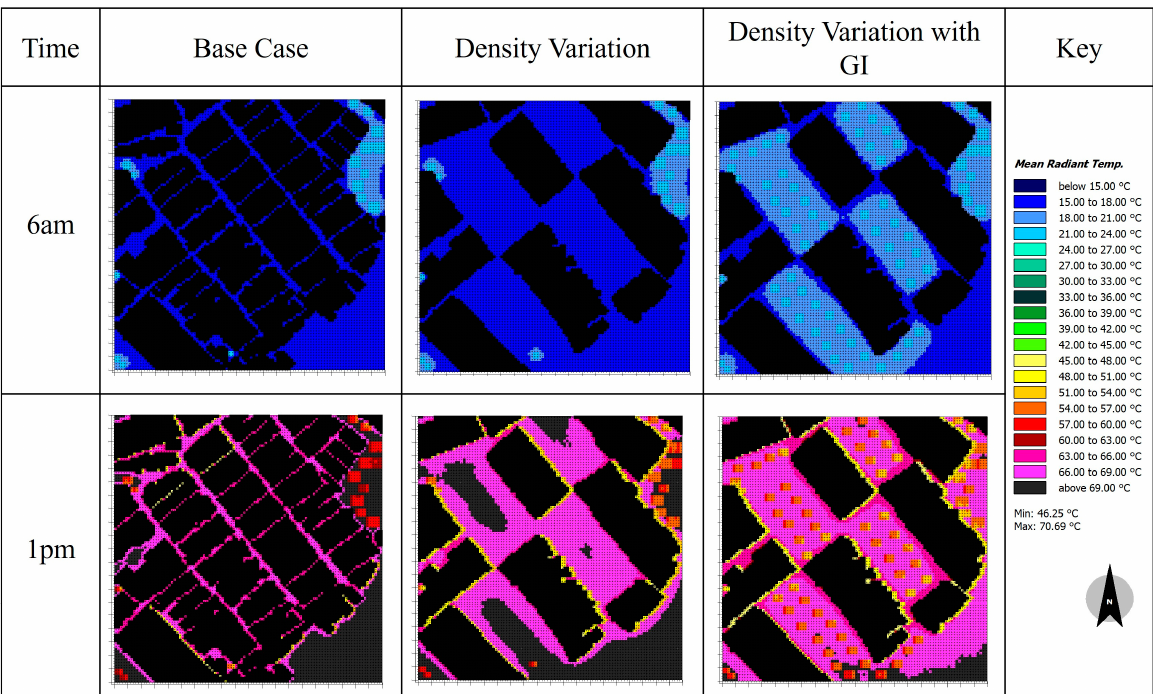
Figure 10. Spatial MRT variations at location 1 for 6 a.m. and 1 p.m.